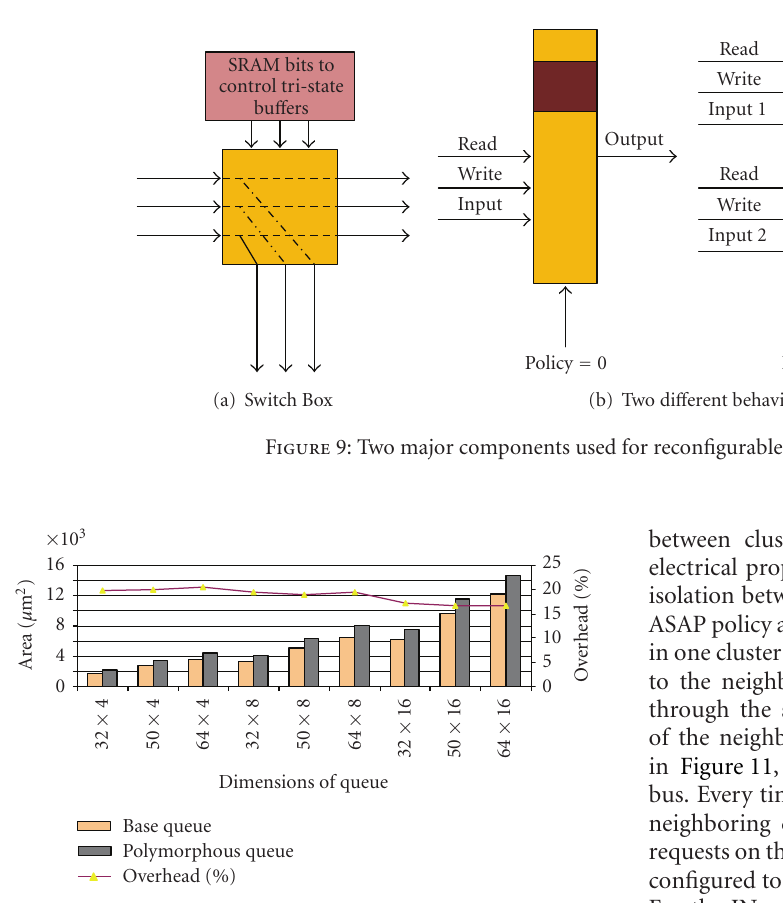
the base queue for di ff erent capacities and bus widths at 65 nm is shown in Figure